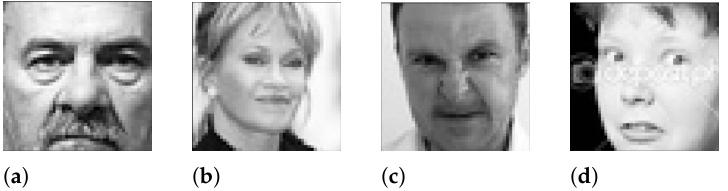
Figure 6. Illustration of sample images misclassified by human participants under all of their 10 versions; ( a ) was classified as anger, but labeled as fear; ( b ) classified neutral, labeled sadness; ( c ) classified anger, labeled disgust; and ( d ) classified fear, labeled